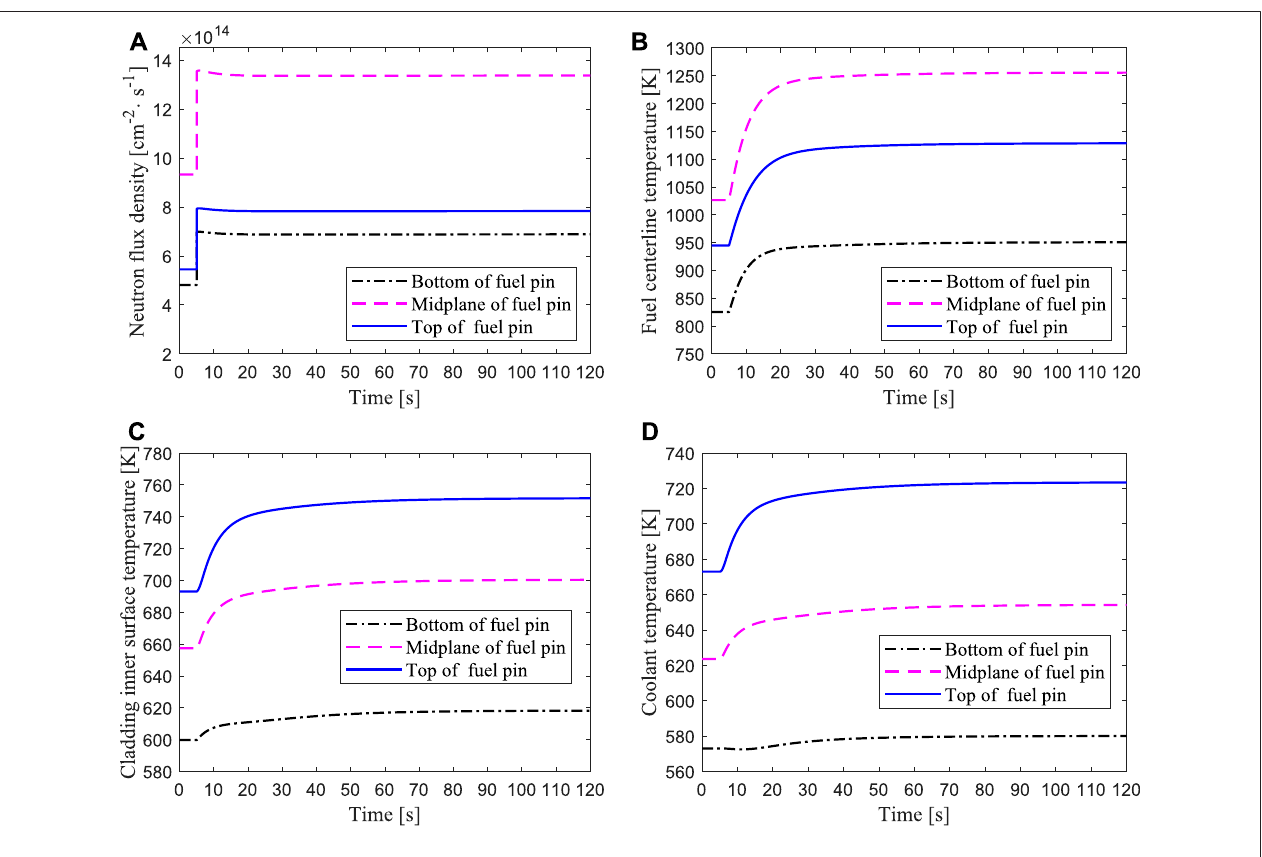
FIGURE 9 | Transient responses of the average channel when the intensity of proton beam increased by